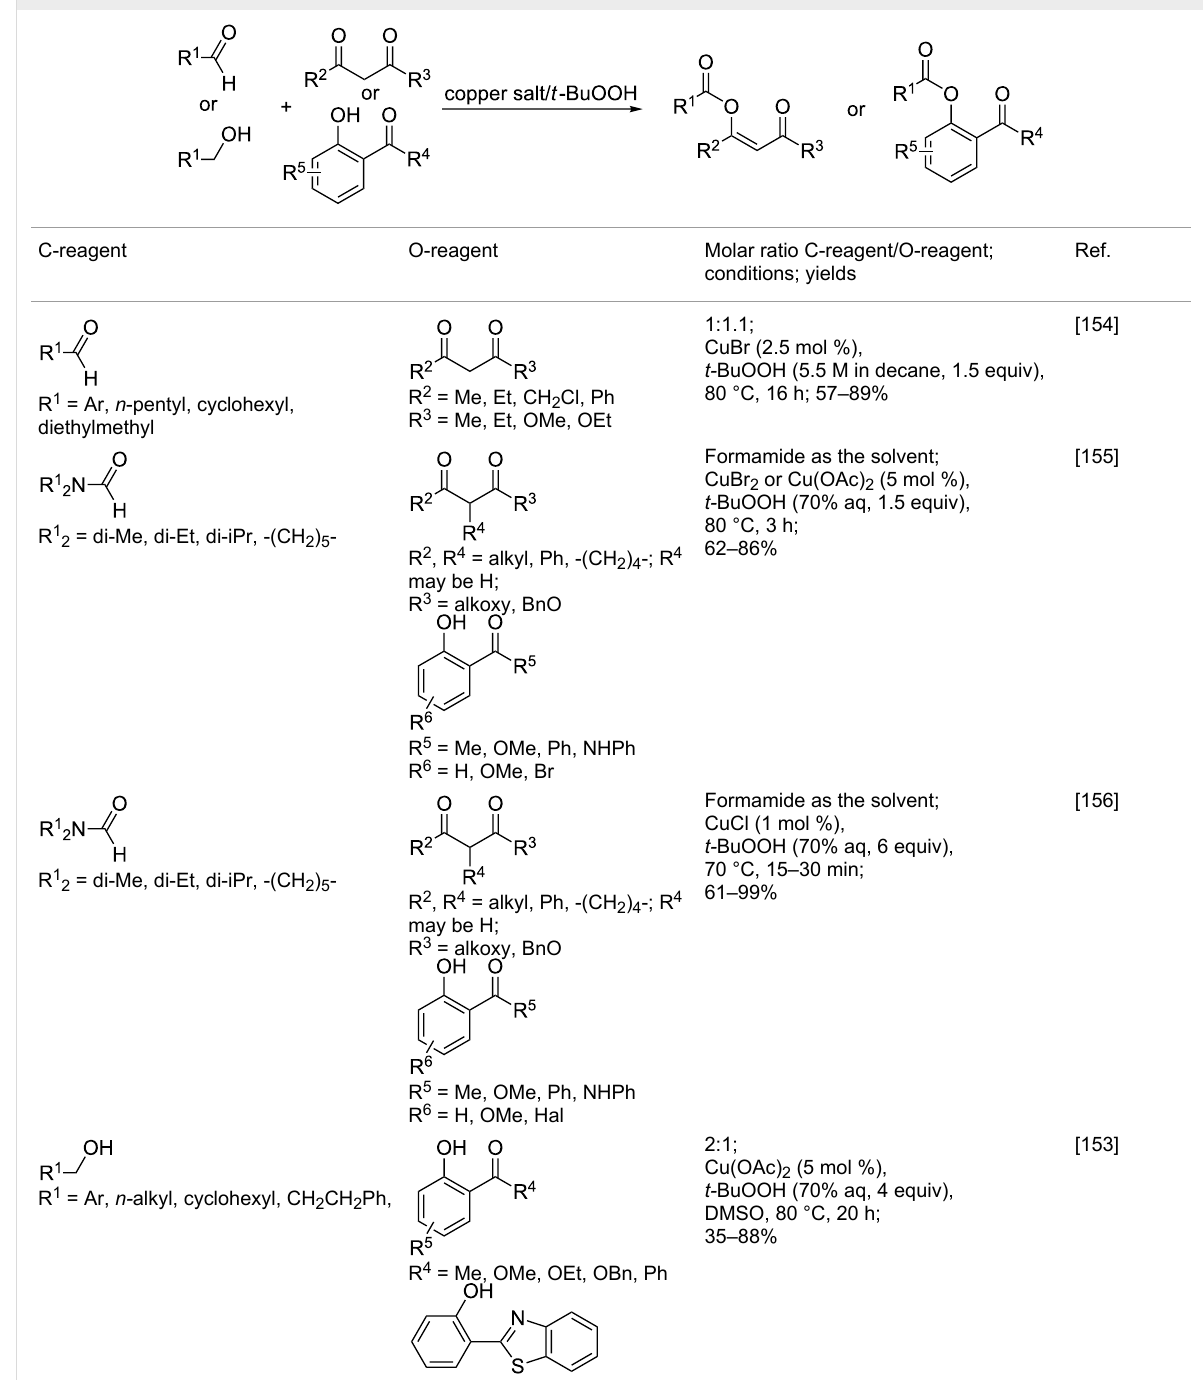
C-reagent O-reagent Molar ratio C-reagent/O-reagent; conditions; yields